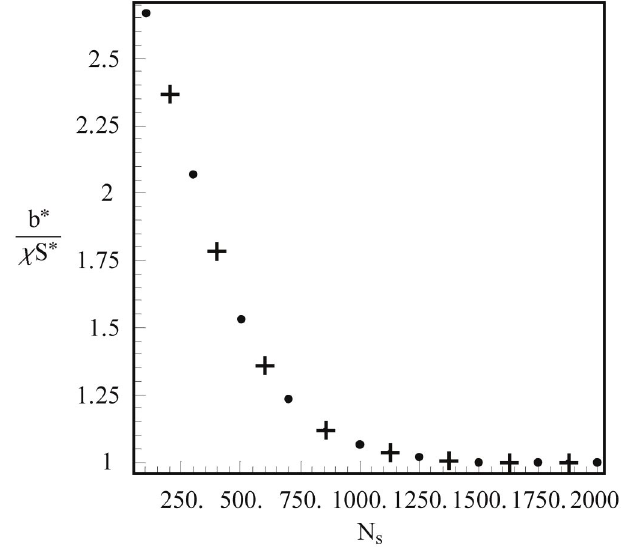
versus b > 11 (cid:6) 0 : 085 . The curve s